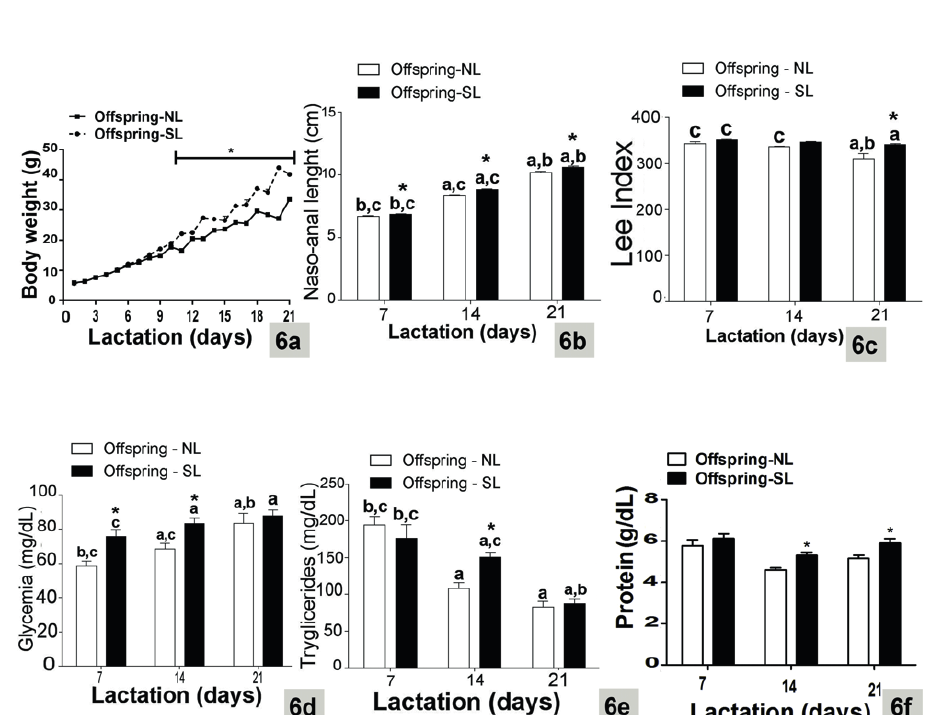
Figure 6 - Biometric parameters and blood biomarkers from SL-offspring and NL-offspring during different lactational phases. The values are expressed as mean ± Standard Error of the Mean (n= 9-12 animals/group). The symbol above bars indicates a significant difference (p<0.05) between the groups (Two-way ANOVA with uncorrected Fisher´s LDS: * SL versus NL; a 7 th day of lactation; b 14 th day of lactation and c 21 st day of